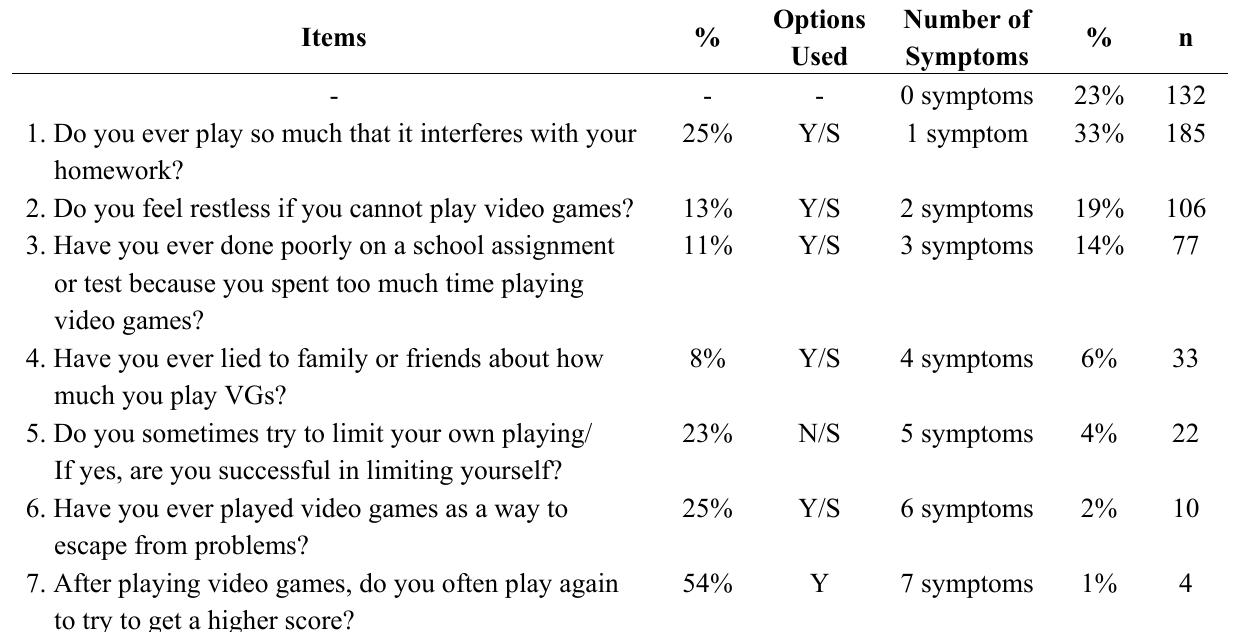
Table 1. Descriptive results for diagnostic items (Study